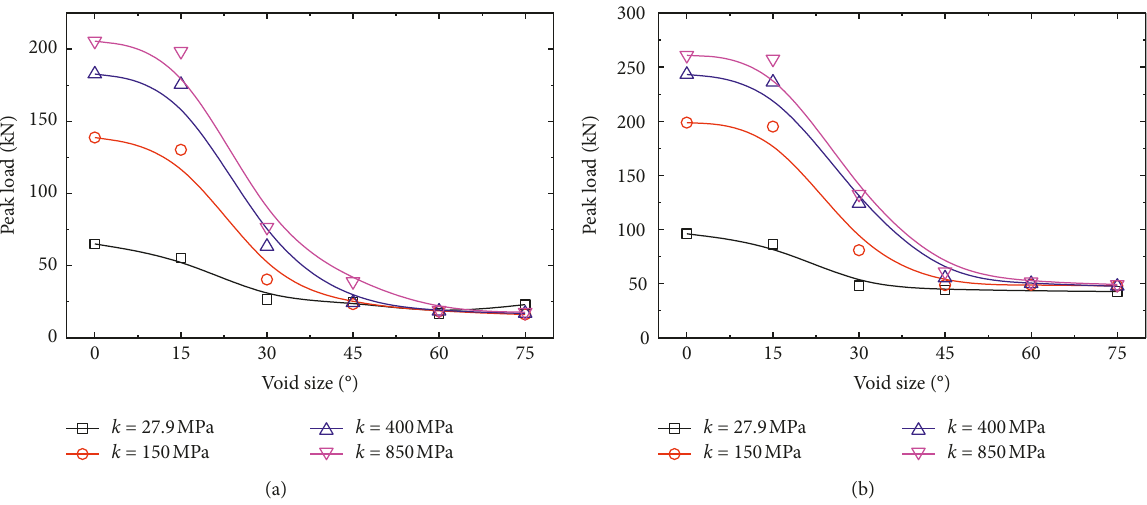
Figure 11: Peak load-spandrel void size relationship curve of the lining. (a) Vertical loading. (b) Horizontal